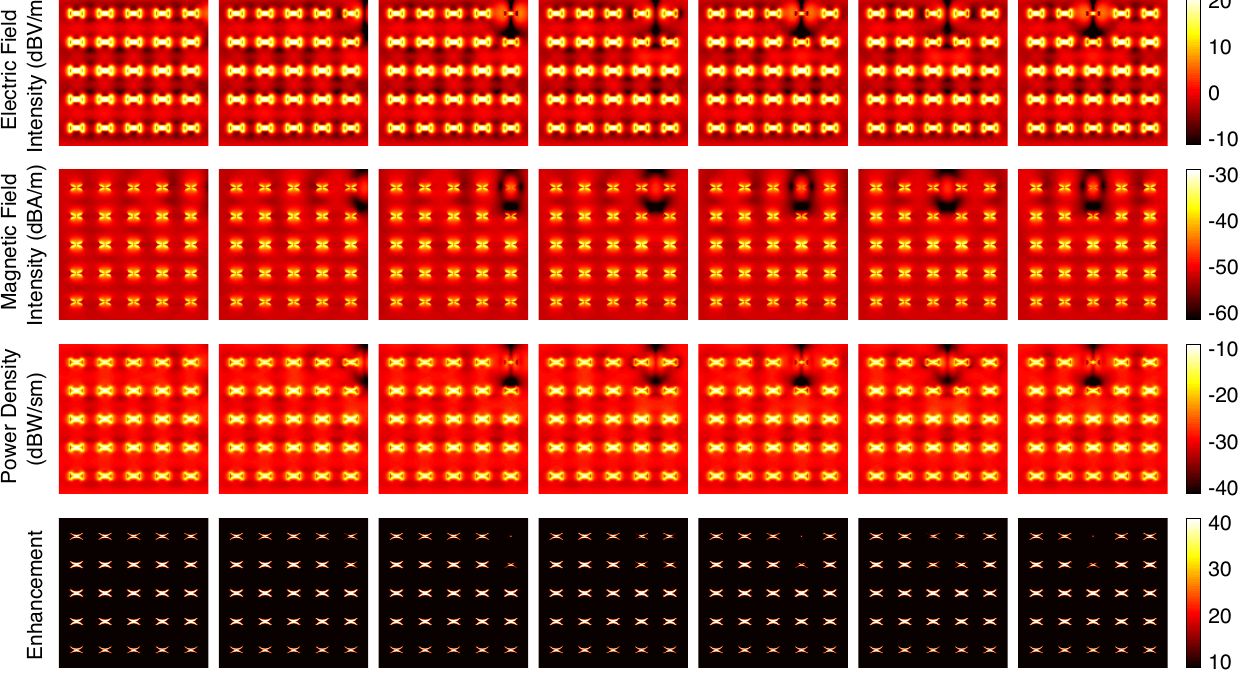
Figure 8: Near-zone characteristics of an array of 5 × 5 nanoantennas when an Ag particle of diameter 600 nm moves above the array as described in Fig. 6(b). The periodicity of the array is 475 nm. The bottom of the particle is 10 nm away from the top surfaces of the